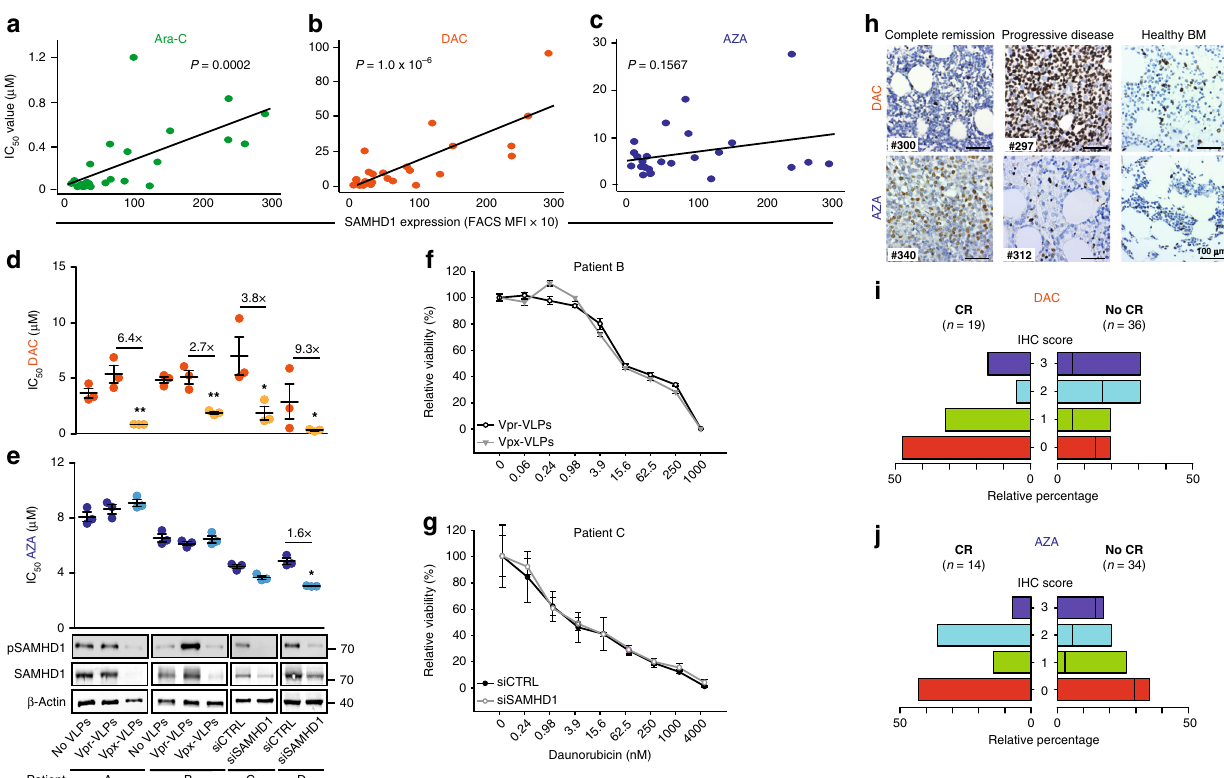
Fig. 6 SAMHD1 expression is a predictive biomarker for DAC therapy in AML. a – c Correlative analyses of SAMHD1 expression and cytotoxicity for ( a ) Ara- C, ( b ) DAC, or ( c ) AZA was performed in bone-marrow-derived blasts from therapy-naive AML patients (blast purities of > 80%). SAMHD1 expression was analyzed by fl ow cytometry. IC 50 measurements were determined in parallel. Data were analyzed by using a generalized log-logistic model. The r2 value indicates goodness-of- fi t of the regression model to the data, and represents variance explained by the independent variable divided by total variance of the IC 50 values for Ara-C. d , e Blasts from four AML patients were either transduced with Vpx- or Vpr-VLPs or left untreated (no VLPs; patients A, B), or transfected with SAMHD1- speci fi c or control siRNAs (patients C, D), and 2 days later, analyzed for cytotoxicity induced by ( d ) AZA or ( e ) DAC. SAMHD1 expression was analyzed by immunoblotting. Horizontal lines and error bars represent means ± s.d. of the IC 50 values. Circles represent single values of one technical triplicate for each patient. The numbers above the data points indicate the factor by which the SAMHD1-depleted and the control groups differed. Statistical analyses were performed using unpaired two-tailed Students ’ t test. f , g Dose – response analyses in patients transduced either with Vpx- or Vpr-VLPs (patient B), or transfected with SAMHD1- speci fi c or control siRNAs (patient C) and subsequently treated with different concentrations of daunorubicin and incubated for 96 h before viability was quanti fi ed by MTT analyses. Values are mean ± s.d. of triplicates of one technical experiment. h Representative IHC micrographs showing SAMHD1 expression in bone marrow (BM) from patients on DAC- or AZA-based therapy with complete remission (CR) (#300, #340) or progressive disease (#297, #312). BM from two healthy donors is shown as reference. Scale bars, 100 μ m. i , j Shown are relative frequencies of patients with IHC scores of 0, 1, 2, or 3 among CR and no-CR patients who had received monotherapy with either ( i ) DAC or ( j ) AZA. The bar for no-CR patients is subdivided into patients with stable disease (left side) and progressive disease (right side)